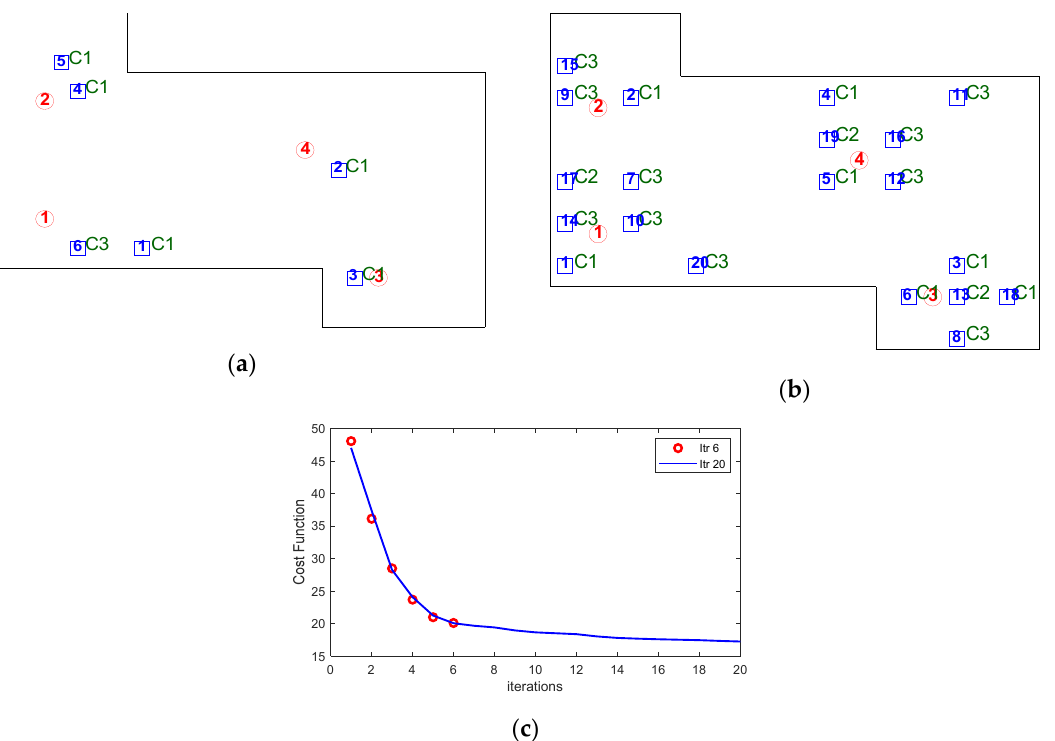
Figure 6. Optimal placement and design of decoupling capacitors for ( a ) 6 and ( b ) 20 iterations (number of decaps); ( c ) comparison between the cost functions for 6 and 20 iterations.